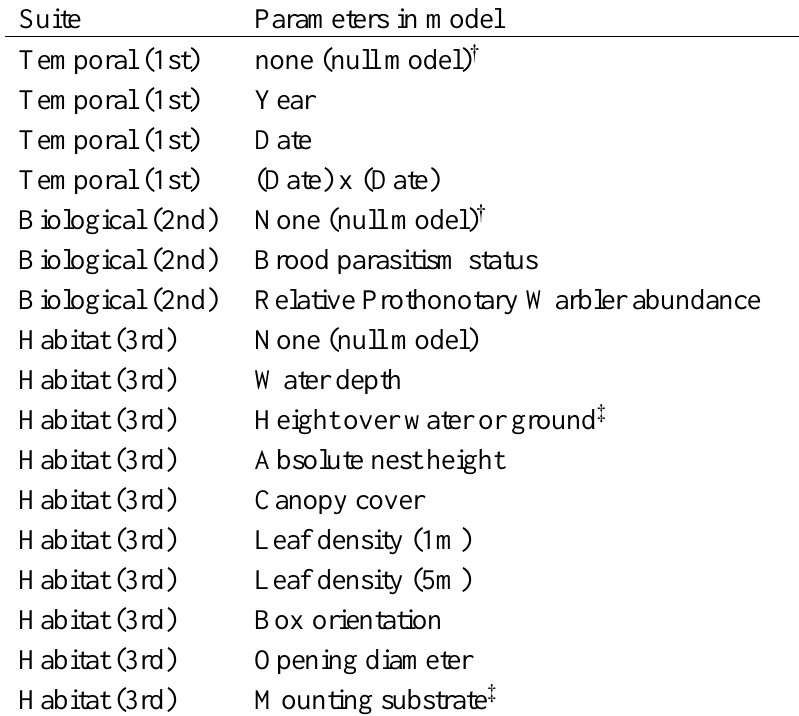
Table A2.2. List of suites built for hierarchical model selection assessing nest survival of Prothonotary Warblers nesting in nest boxes in White River National Wildlife Refuge, Arkansas, USA in 2014-2015. Each model was a logistic exposure model (built in Program MARK) assessing the relationship between daily nest survival rate (dependent variable) and independent variables organized into hierarchical suites of temporal, biological, and habitat variables. Top model of each suite ( † ) was carried on to the next suite as the new suite's null model, and parameters from this model were added to the new suite's models. If no model was better than the null model, the null model was carried on to the next suite. In the text, we report the parameters of the final top model or models ( ‡ ). All models we built and compared in Program